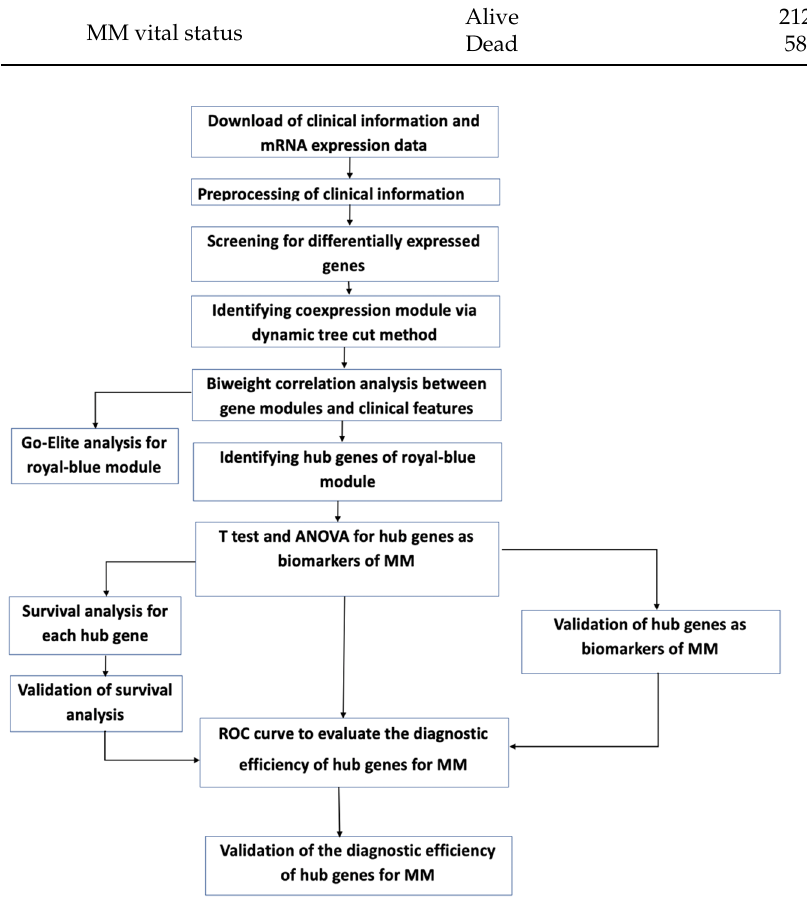
Figure 1. Workflow for the analysis of gene expression and clinical data.